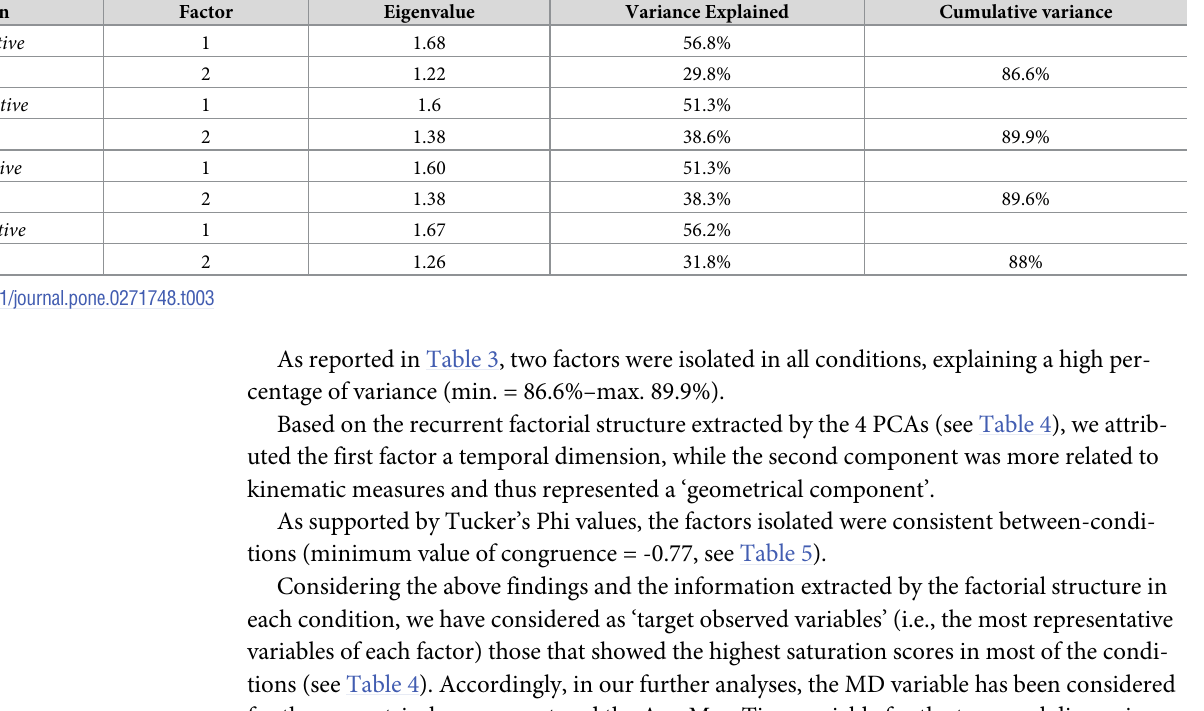
Table 3. Eigenvalues ( > 1), percentage of variance explained by each factor, and percentage of cumulative variance explained by the factorial solution with 2 factors in all the four